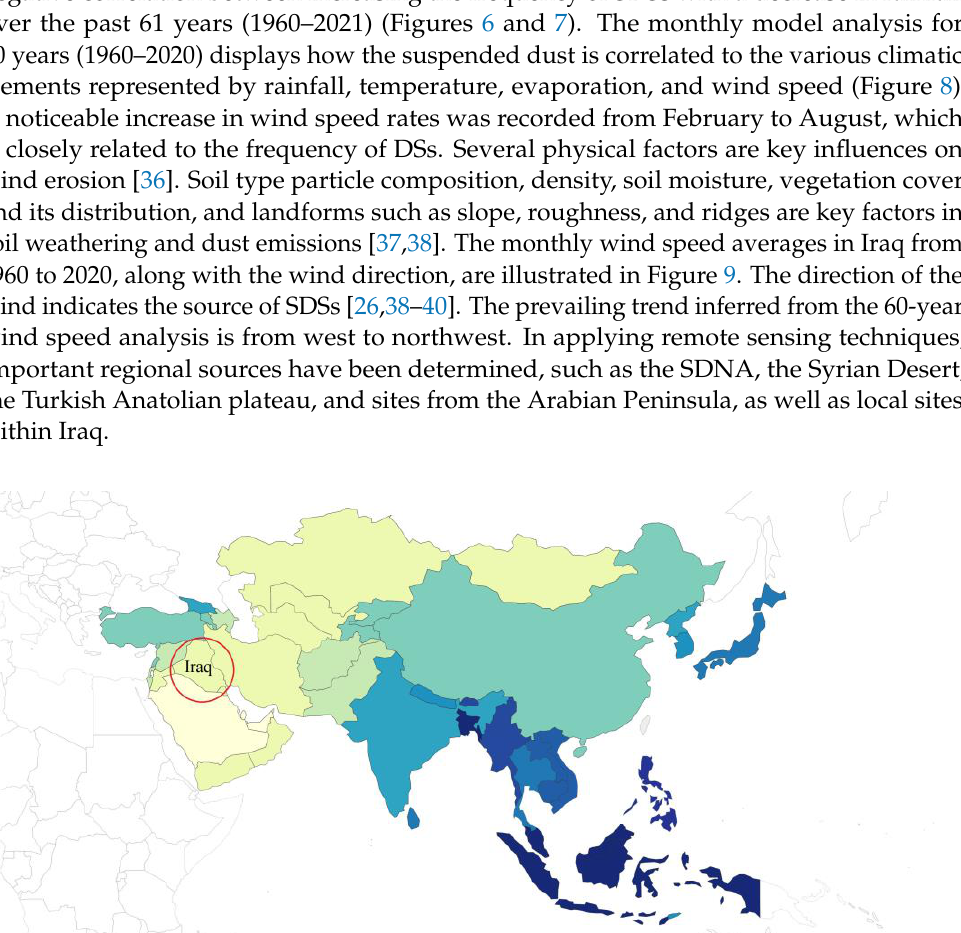
Figure 4. ( a ), Annual CO 2 emissions in Iraq from fossil fuels and industry (1927 – 2020), land use changes are not included; ( b ), cumulative CO 2 emissions show the total sum of CO 2 produced from fossil fuels and cement since 1950, land use changes are not included; ( c ), carbon dioxide emitted from fuel in Iraq.